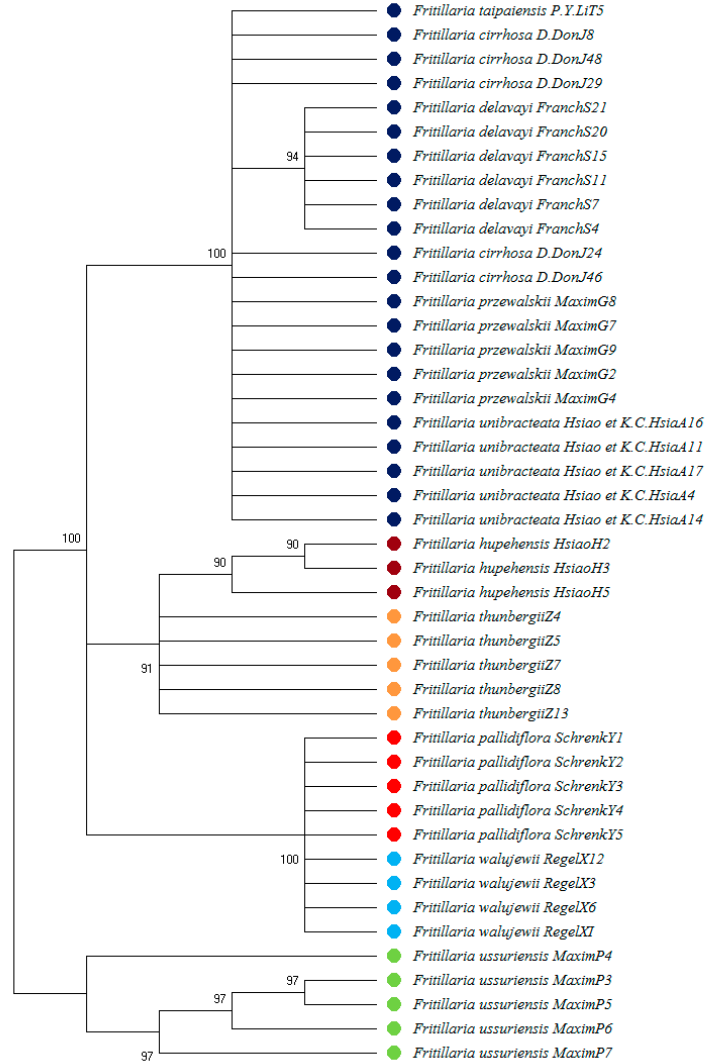
Figure 3. Neighbour-joining (NJ) tree based on ITS sequences.